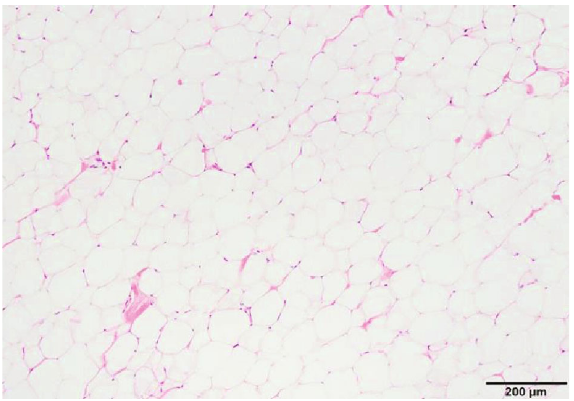
Figure 5: Pathological fi ndings. The tumor was formed by hyperplasia of mature